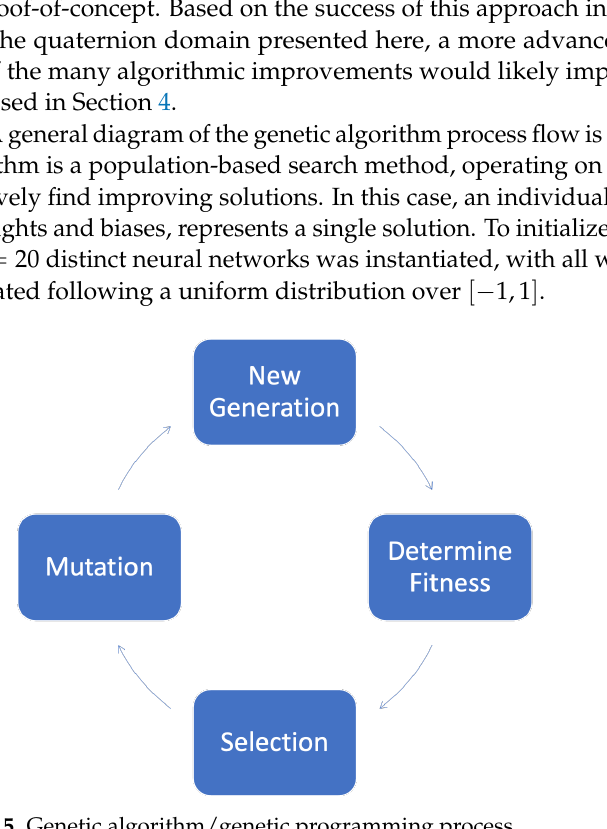
Figure 5. Genetic algorithm/genetic programming